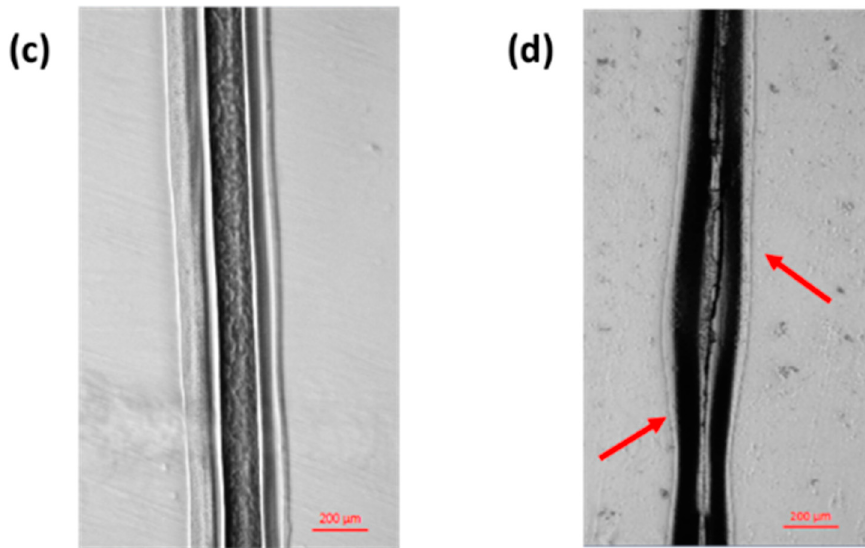
Figure 3. Pluronic hydrogel printed strand under 5 × magnification optical microscope at ( a ) 25G nozzle, 3 × 10 5 Pa, 0.01 m/s speed; ( b ) 27G nozzle, 3 × 10 5 Pa, 0.01 m/s speed; ( c ) 21G nozzle, 1 × 10 5 Pa, 0.02 m/s speed; ( d ) 21G nozzle, 1 × 10 5 Pa, 0.03 m/s speed, where red arrows point to the line defects (scale bar = 200 µ m).